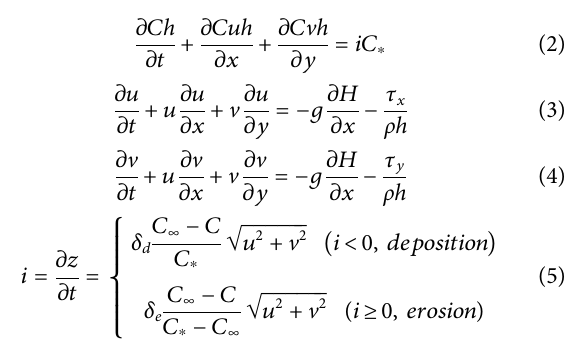
Frontiers in Earth Science |